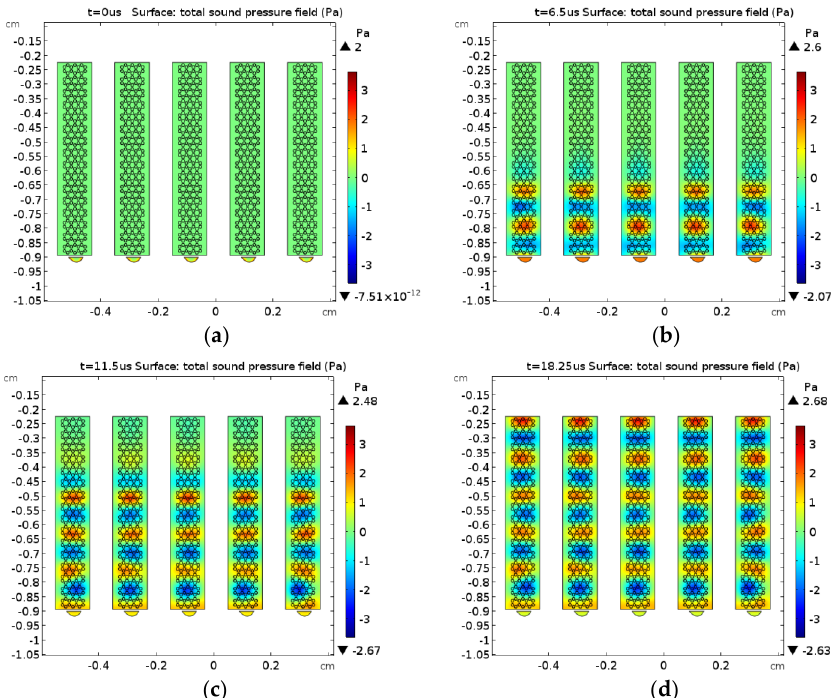
Figure 4. Simulation results in different time periods: ( a ) sound pressure diagram at 0 µ s; ( b ) sound pressure diagram at 6.5 µ s; ( c ) sound pressure diagram at 11.5 µ s; ( d ) sound pressure diagram at 18.25 µ s